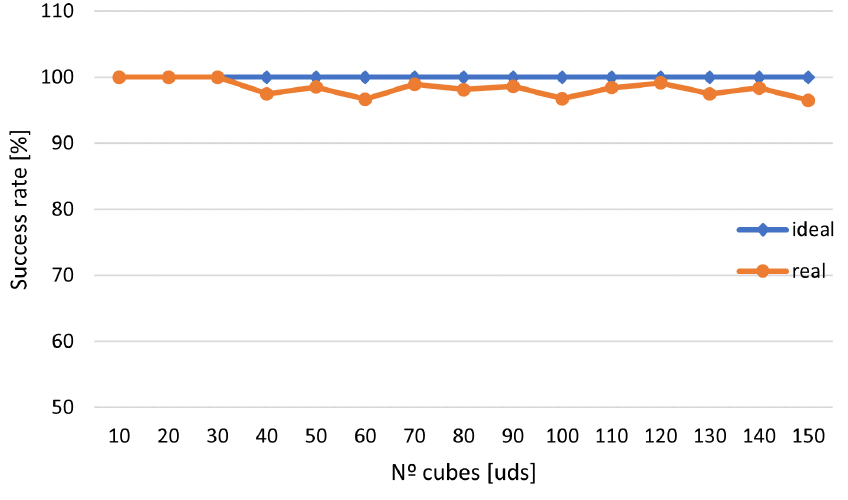
Figure 10. Success rate for cube